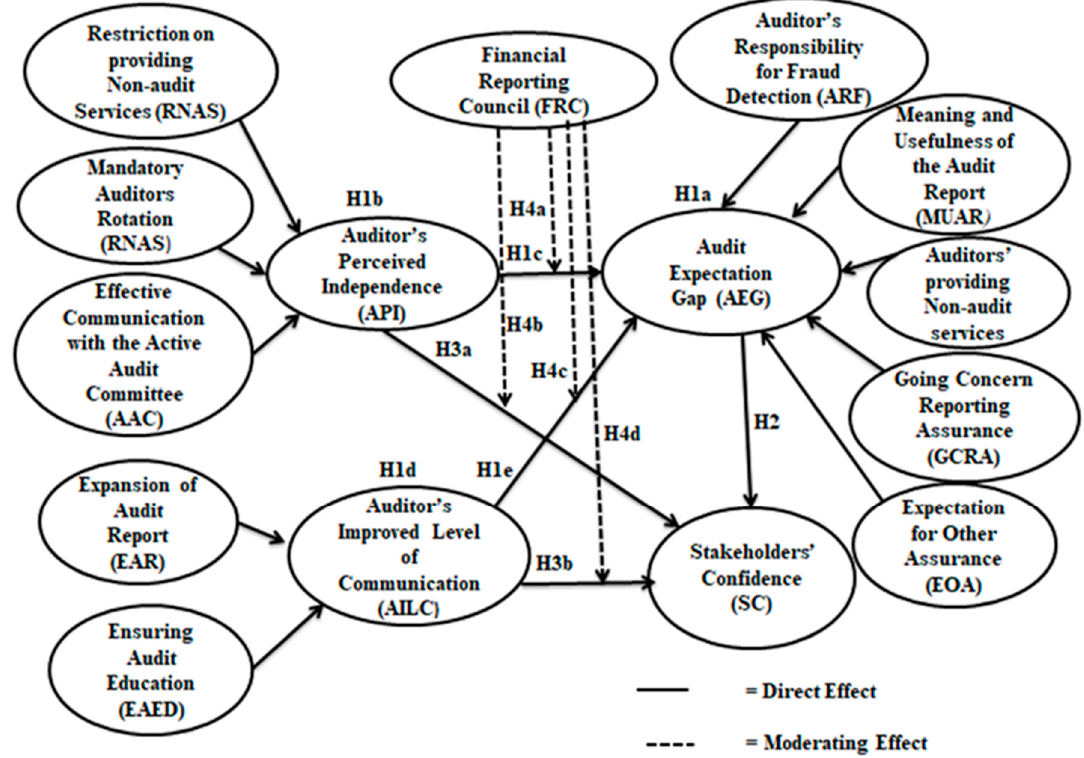
Figure 1. Conceptual model.